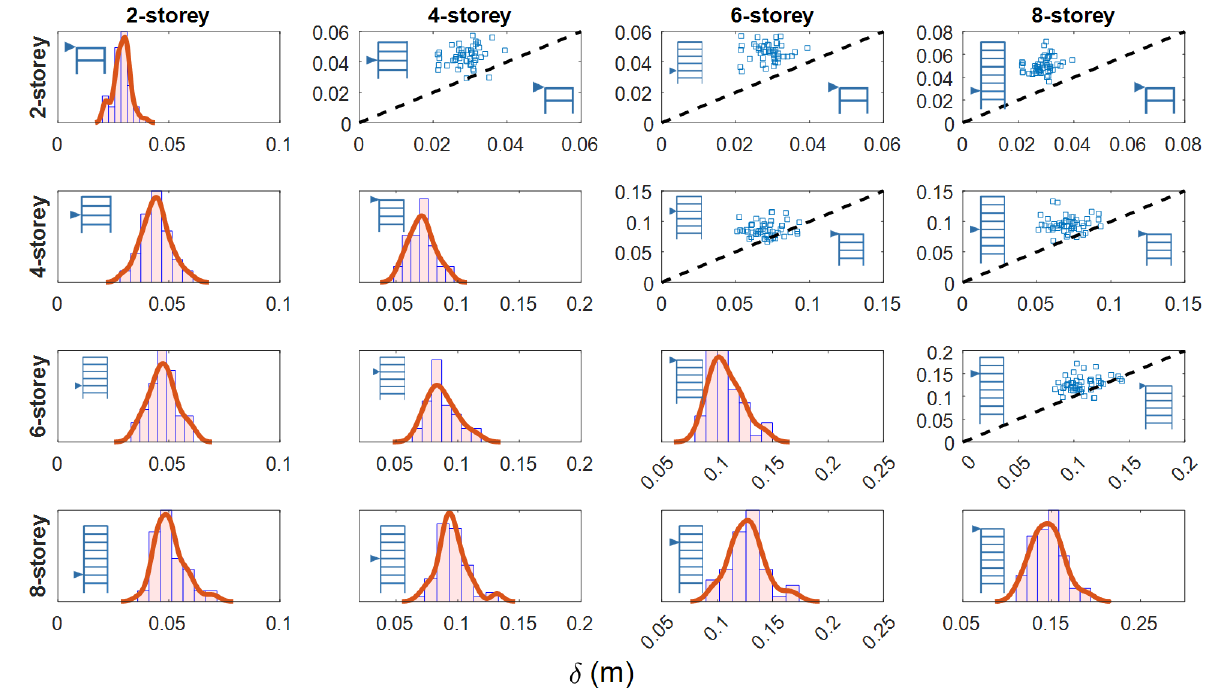
Figure 11. Histograms (diagonal and lower diagonal plots) of the maximum displacement at several storeys, and scatter plots (upper diagonal plots) of the maximum top displacement obtained for a given structure along with the corresponding maximum displacement obtained at that same level in taller structures. Table 1. Statistics of the lateral displacement of the structures at different levels obtained from dynamic analyses, spectral displacement of the structures, and reference values G of the separation distance for pairs of adjacent buildings.